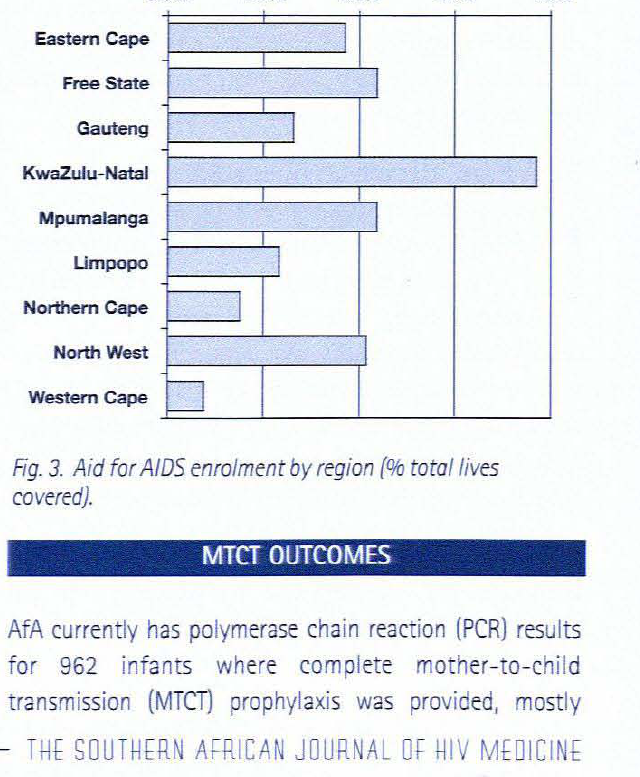
Fig. 2. Aid for AIDS enralment by age {% total lives covered}. Fig. 7. Cumulative enralment ofpatients onto the Aid far AIDS